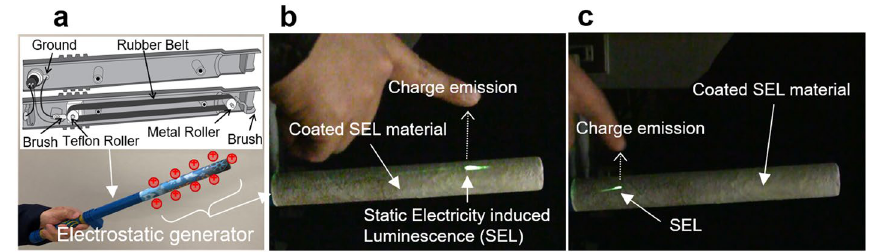
Figure 3. Static electricity induced luminescence (SEL) at places where charges were emitted from a Van de Graaff-type electrostatic generator to a finger. ( a ) Scheme of electrostatic charge generation. ( b ) SEL due to discharge between the finger and the electrostatic generator. ( c ) SEL when the finger is moved from left to right.